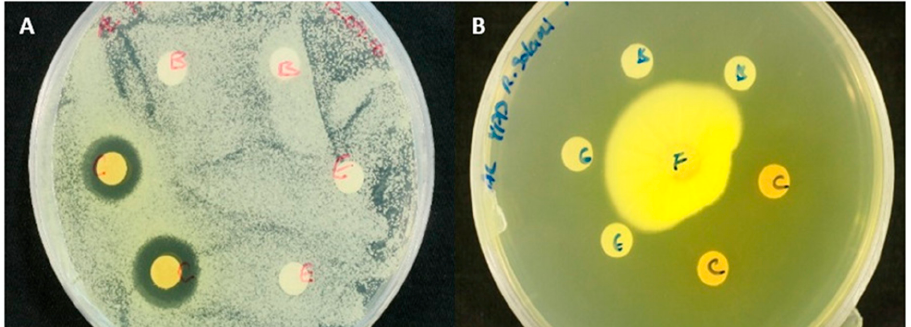
Figure 3. Agar diffusion assays of crude methanol extract obtained from Epicoccum nigrum cultures. Different concentrations of crude extract were tested against Saccharomyces cerevisiae ( A ) and Rhizoctonia solani ( B ). These were compared against solvent blank (paper disks B).